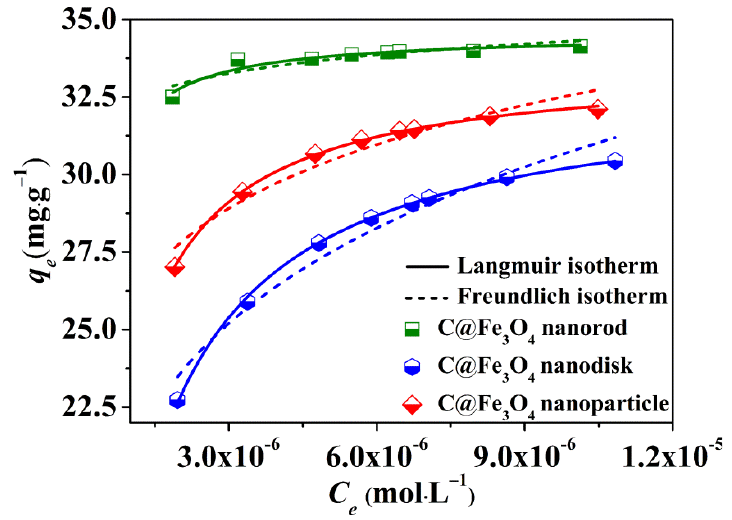
Figure 10. Two isotherms for MB adsorption on three C@Fe 3 O 4 composites at 298.15 K (the scatter plots represent the adsorption data, the solid line represents the Langmuir isotherm model and the dash line represents the Freundlich isotherm model).